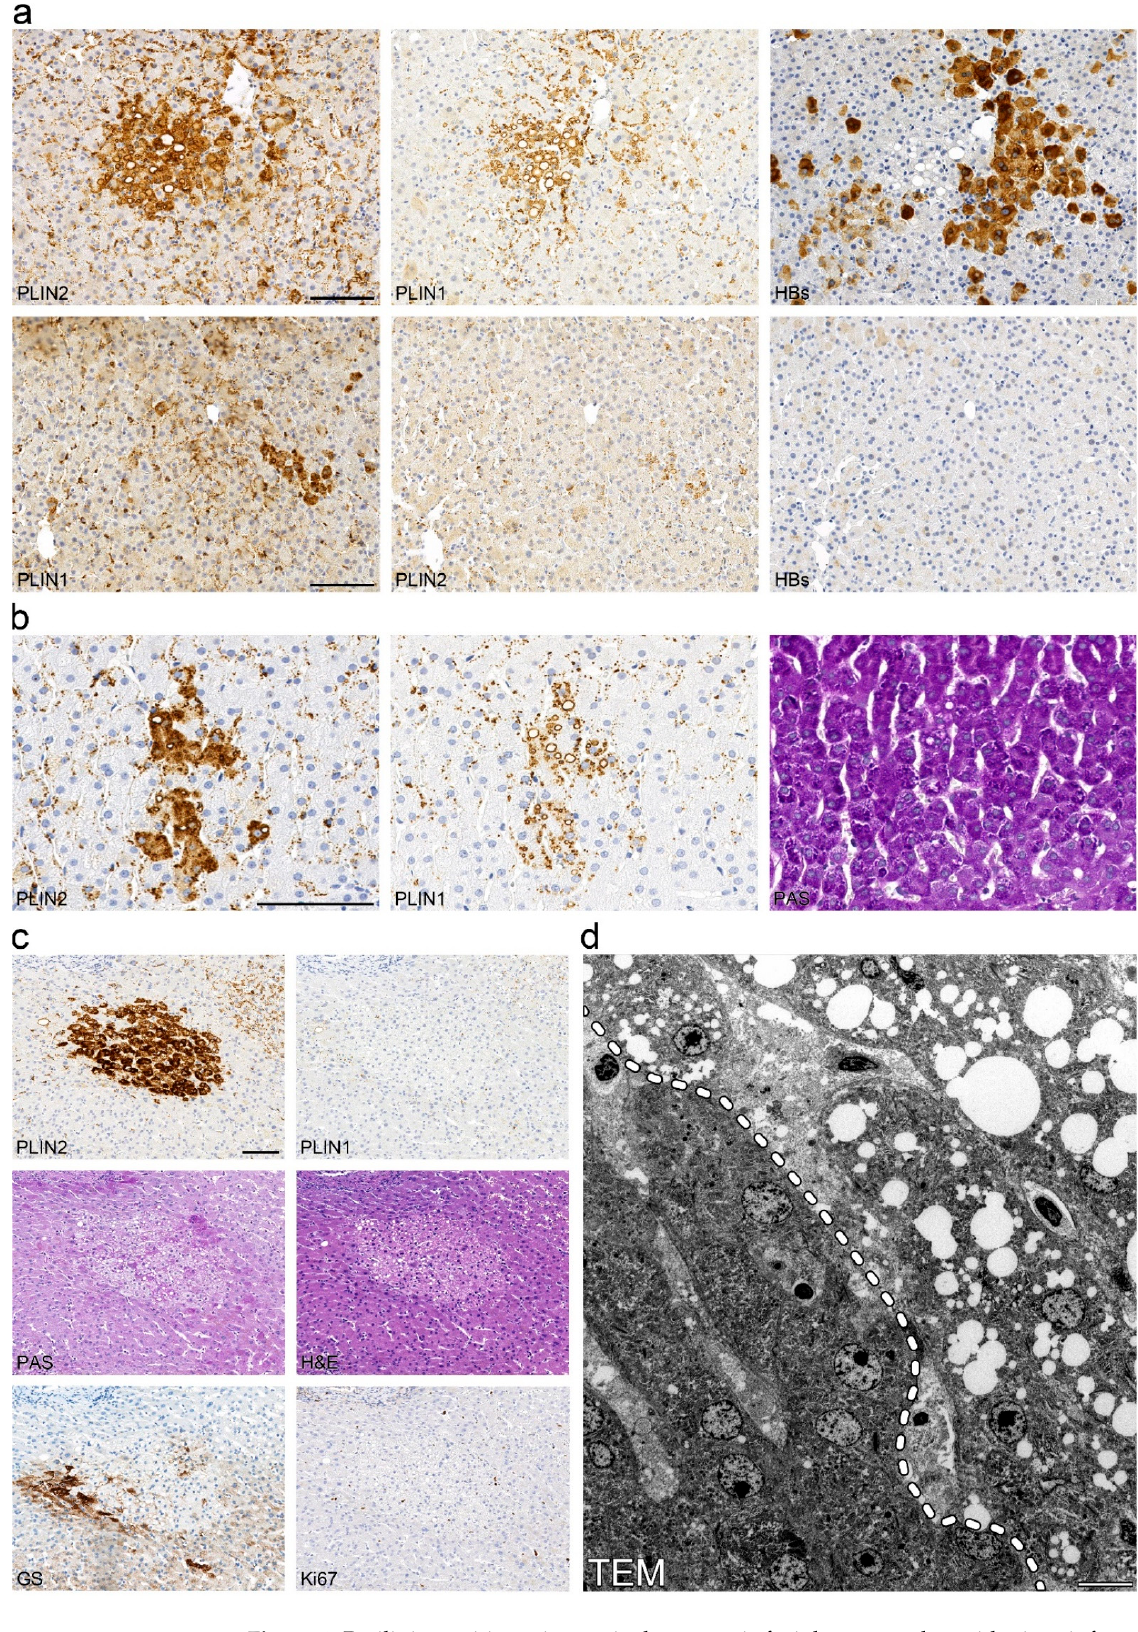
Figure 4. Perilipin-positive microvesicular steatotic foci do not overlap with virus-infected clusters and may also be found in other chronic liver diseases. ( a ) Immunohistochemical analysis of perilipins 1 and 2, and hepatitis B surface antigen (HBs) in consecutive sections of liver biopsies with chronic hepatitis B. Steatotic foci with (upper panel) or without (lower panel) detectable HBs-Ag